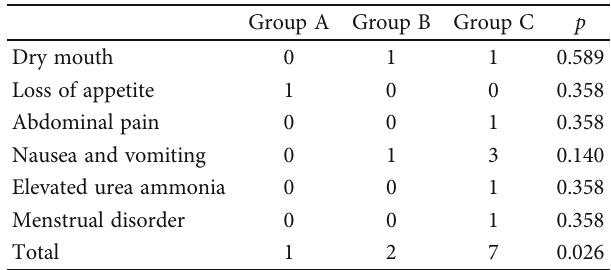
Table 3: Comparison of adverse reactions among three groups.